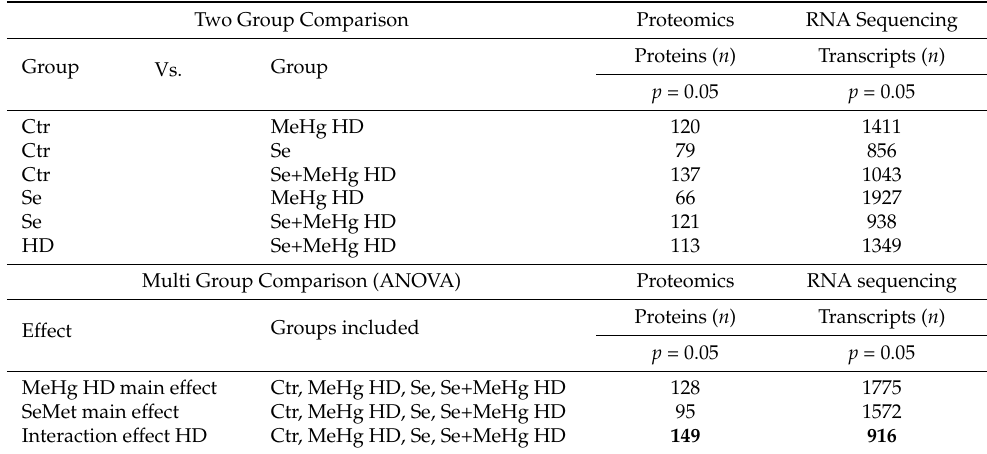
Table 2. Summary of the numbers of differentially expressed proteins and RNA transcripts ( p ≤ 0.05) according to different statistical comparisons in Qlucore Omics Explorer. The proteins and transcripts indicated by numbers in bold are used for further analysis in the Ingenuity Pathway Analysis software (IPA), upon which findings are described in Table